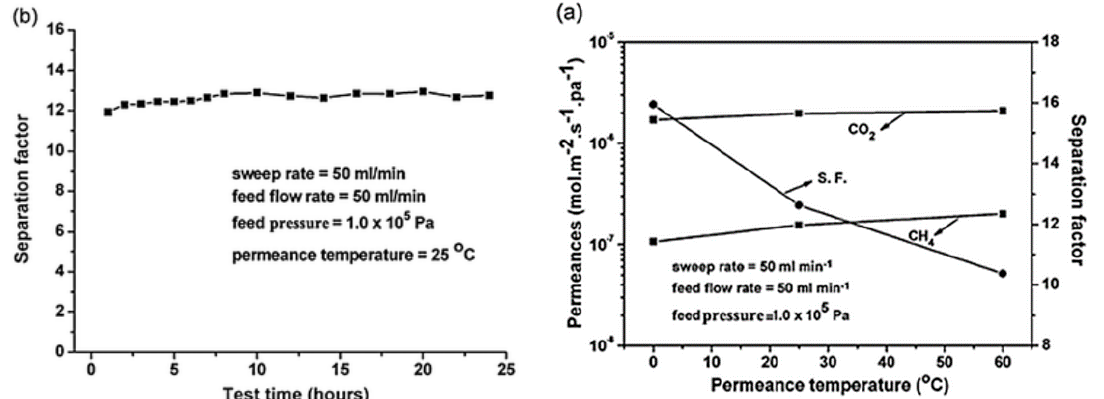
Figure 48. ( a ) CO 2 /CH 4 permeance and separation factor (SF) of the Co 3 (HCOO) 6 membrane versus permeation temperature. ( b ) Plot of the CO 2 /CH4 separation factor of the Co 3 (HCOO) 6 membrane as a function of test time (adapted with permission from ref. [146]).